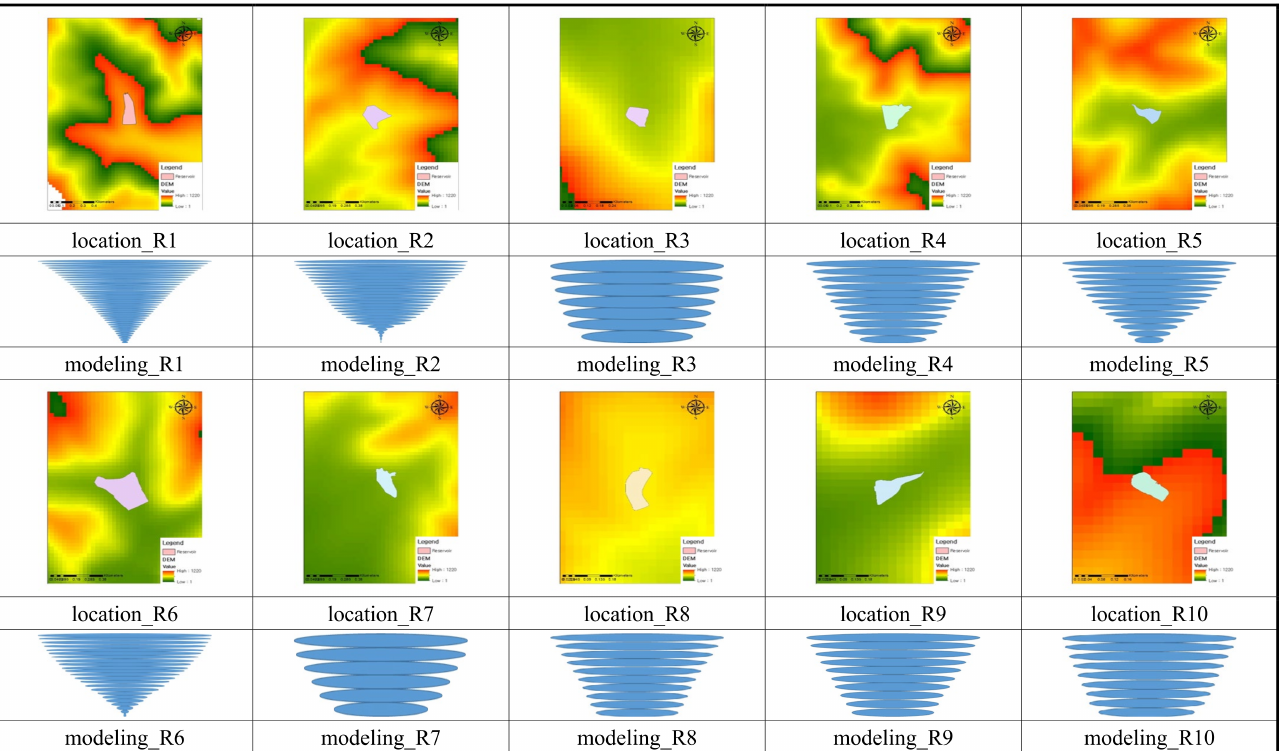
Figure 5. Locations and modelling of the reservoirs: For the ten reservoirs, including the Ga-Gog Reservoir, topographic information was constructed using topographical maps and GIS techniques.